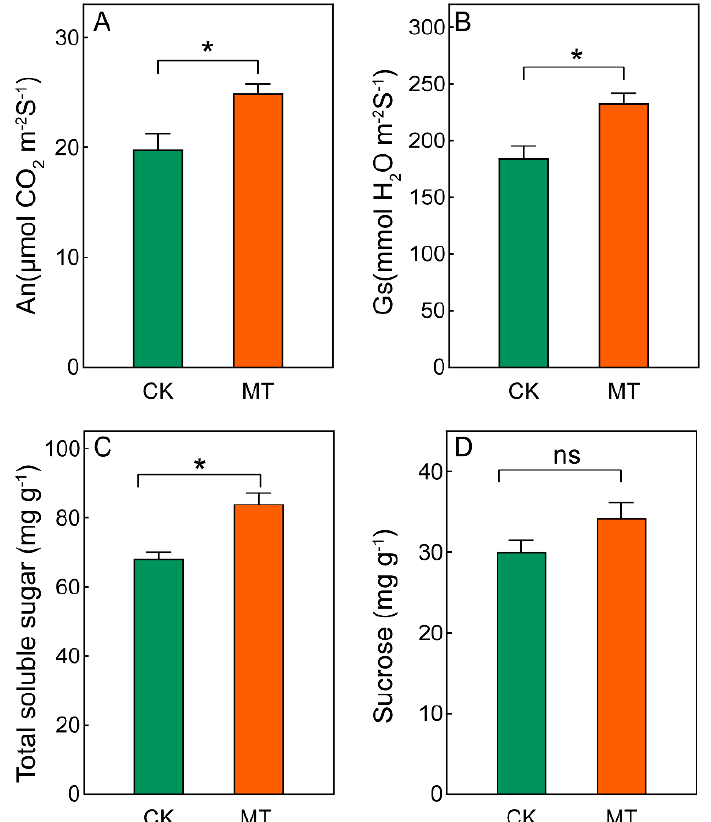
Figure 4. Photosynthetic rate (An) ( A ), stomatal conductance (g s ) ( B ), total soluble sugar concentra- tion ( C ), and sucrose concentration ( D ) in the leaves of Phragmites australis under control (CK) and melatonin (MT) conditions. “ns” indicates not significant and “*” indicates significance at p < 0.05. Data are expressed as means ± SE (n = 3).